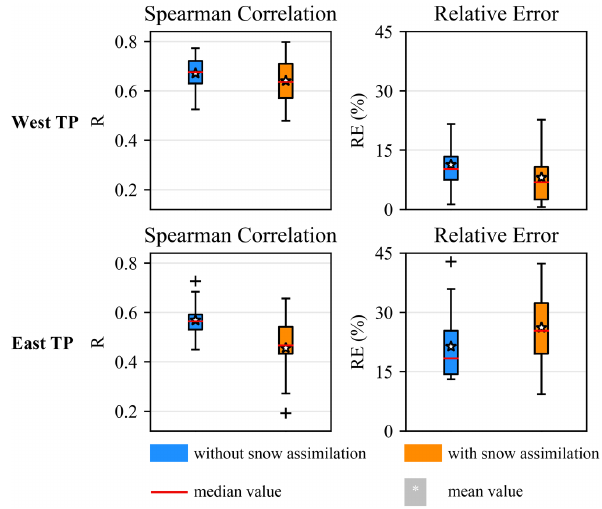
Figure 12. The Spearman’s correlation coefficients and mean abso- lute relative error in daily precipitation between the two ensemble reforecasts and GPM